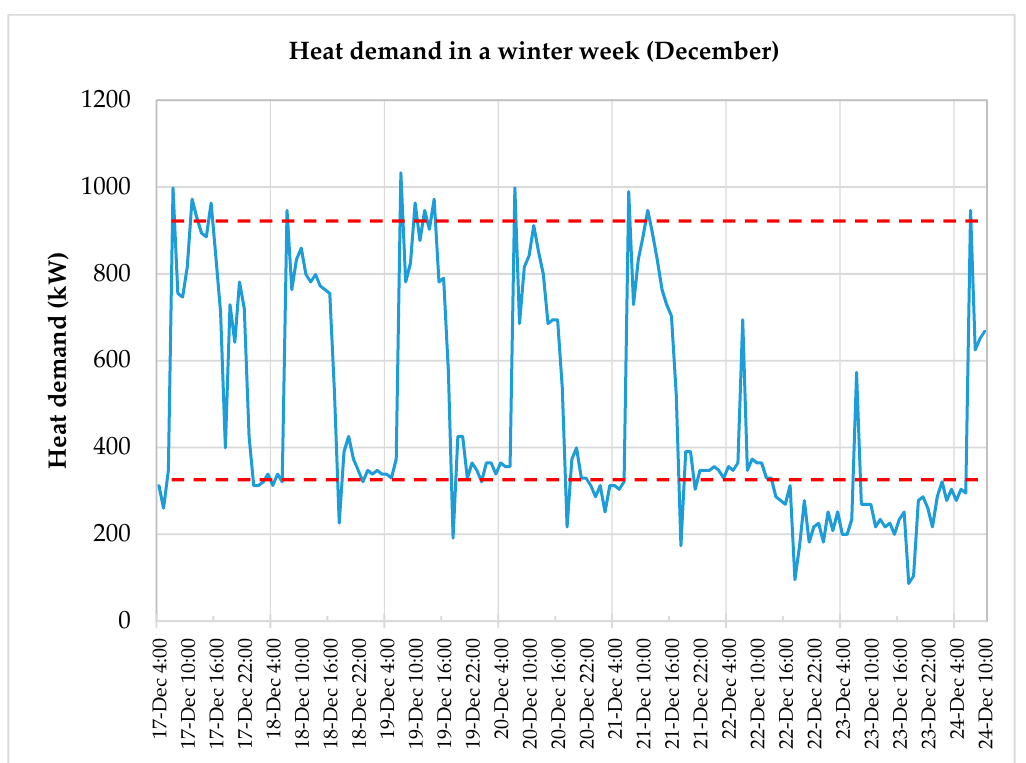
Figure 14. Heat demand in a winter week (December).